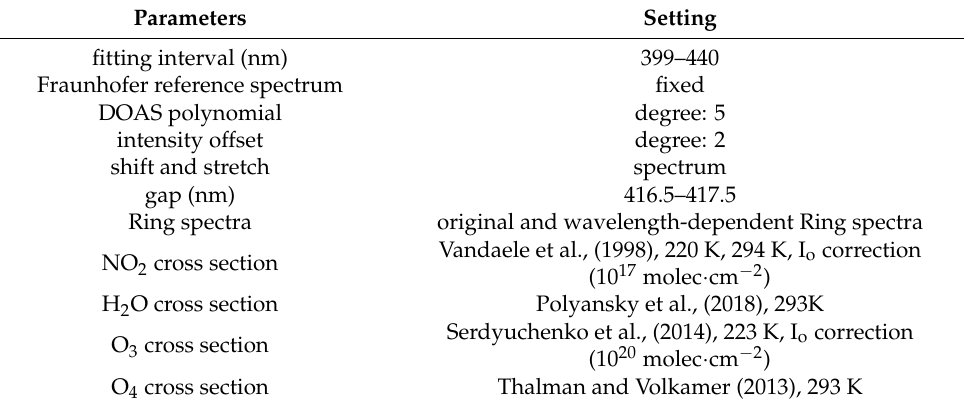
Table A2. Fit settings for the NO 2 spectral analyses.